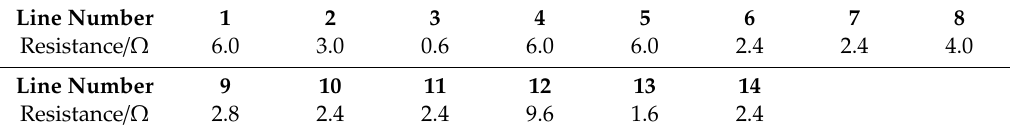
Table A5. The monopolar line resistance of the 13-terminal VSC-MTDC system.